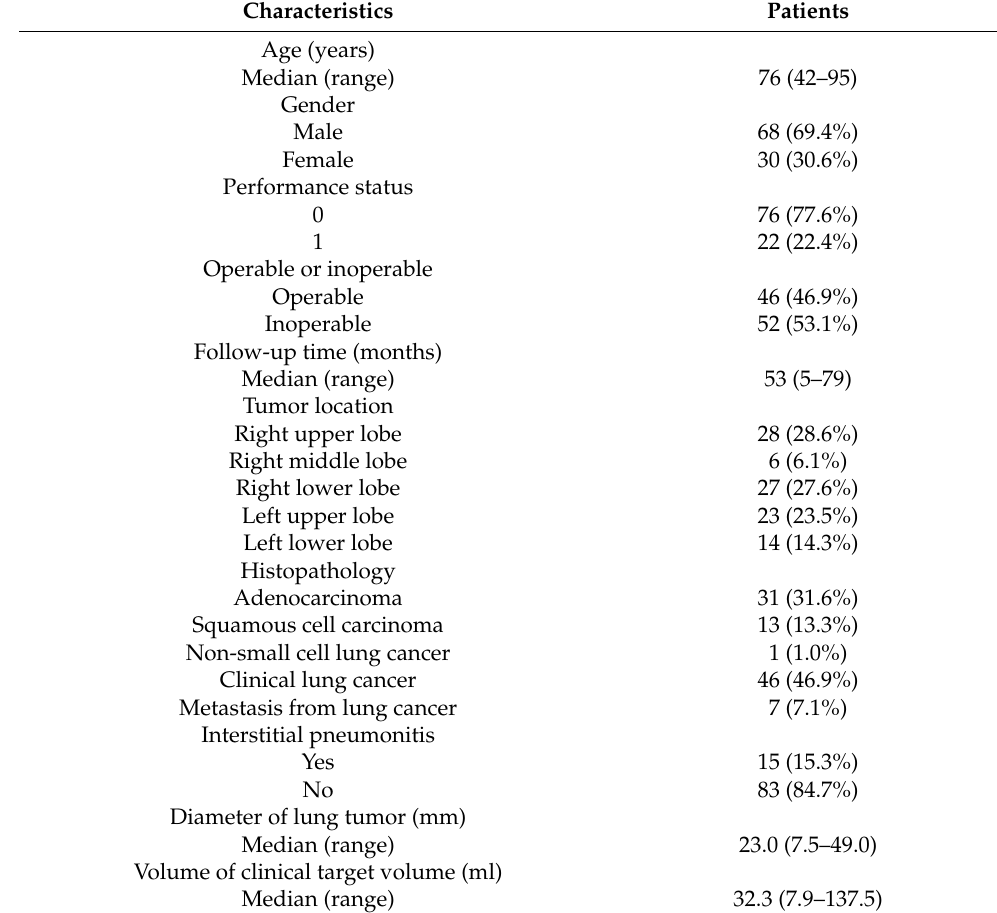
Table 1. The patient characteristics ( n = 98).